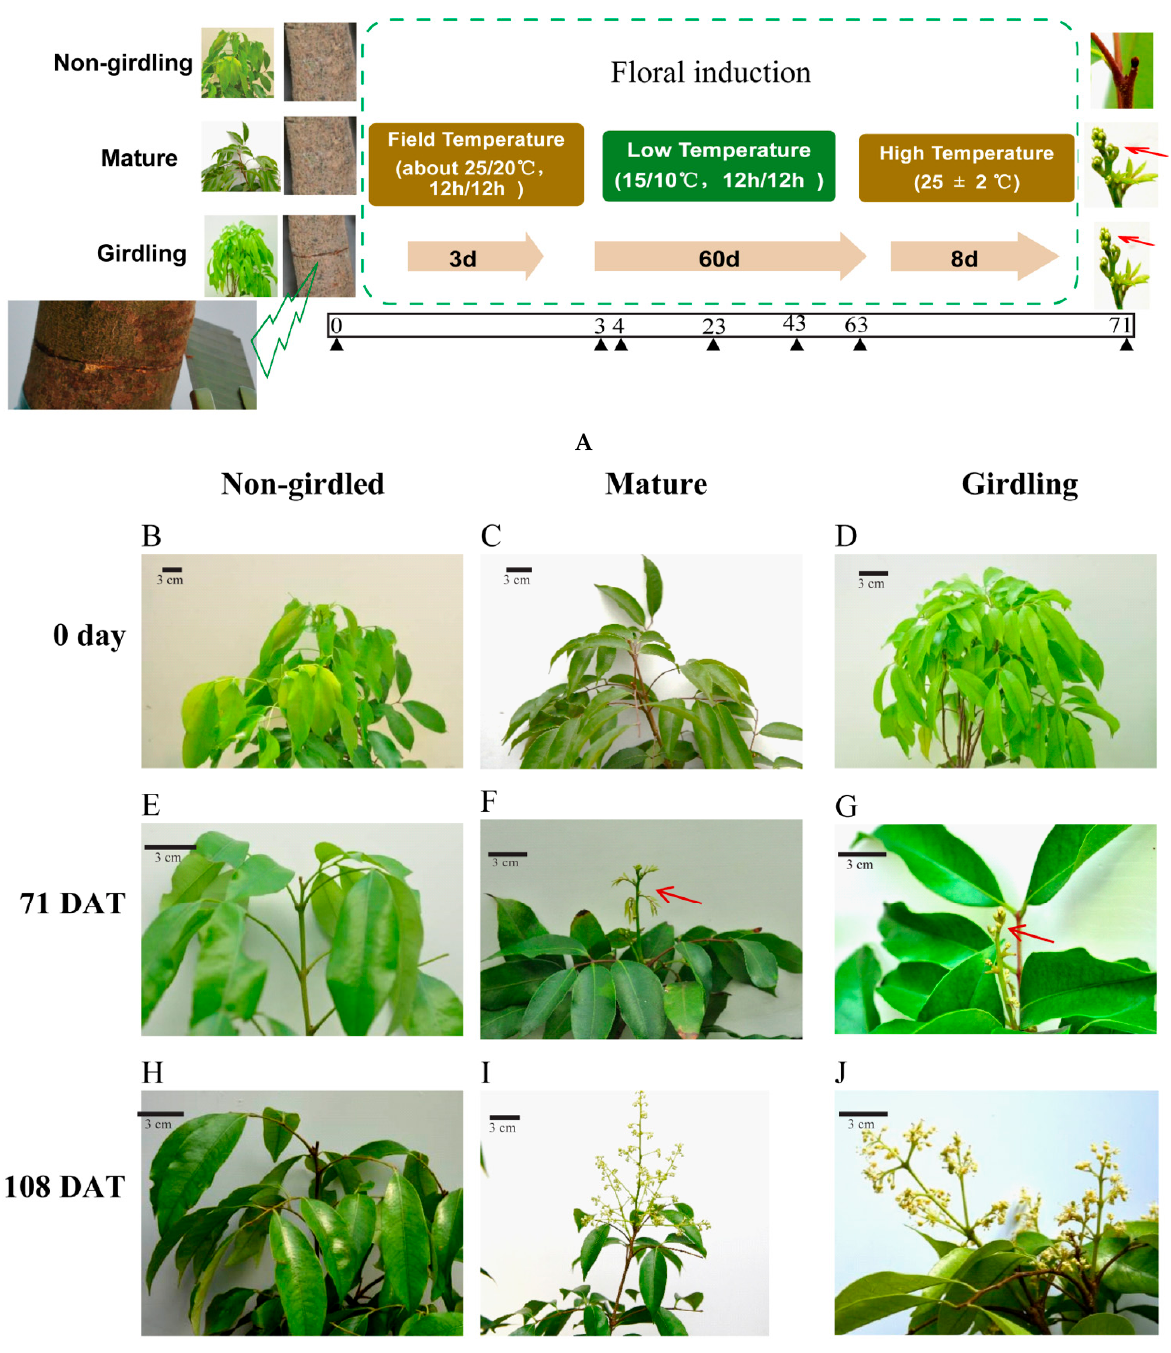
Figure 1. Experimental schematic and the effect of stem girdling on litchi flowering. ( A ): Schematic of the experimental treatments. The black triangles indicate the time of sampling. ( B – J ): Non-girdled, mature, and girdled Litchi trees displayed variation in flowering after floral induction. ( B – D ): Representative photographs of the terminal flush on trees before any treatment on 0 day. ( E – G ): Representative photographs of trees after floral induction. ( E , H ): Representative photographs of non-girdled trees that did not form inflorescences primordium. ( F , G ): Representative photographs of trees formed inflorescences primordium. The red arrows indicate inflorescences primordium. ( I , J ): Representative photographs of trees bloomed. DAT is the abbreviation of days after treatment. The apical leaves of the terminal flushes in girdling trees and non-girdled trees were expanded to full size completely and displayed light green. The apical leaves of the terminal flushed in mature trees were fully mature.